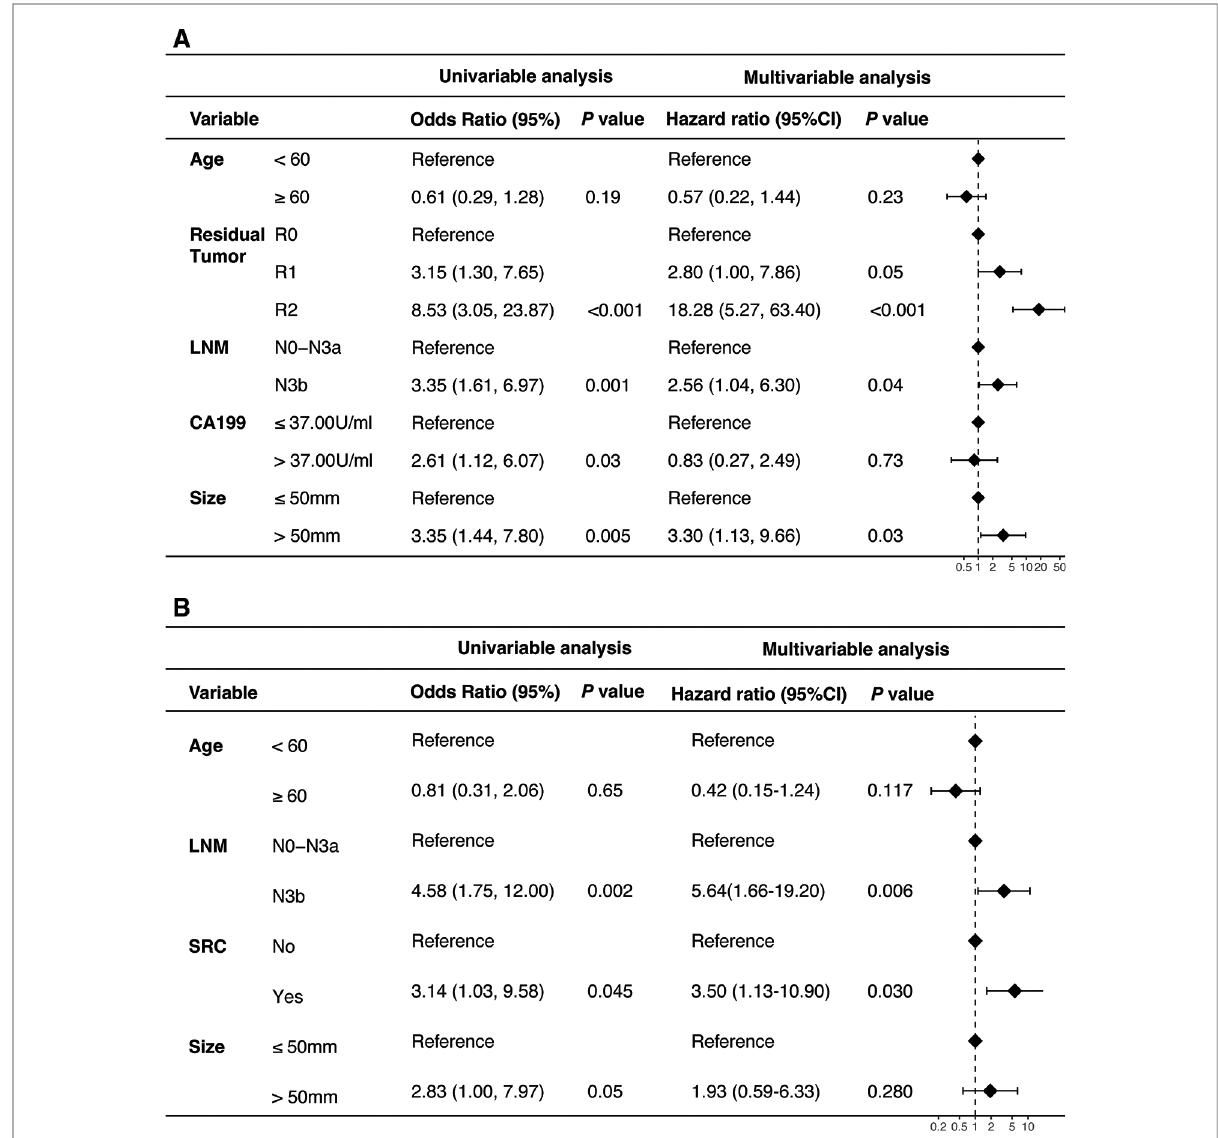
FIGURE 4 Cox proportional hazard regression models and forest plot for recurrence free survival. ( A ) Forest plot of data from multivariate cox regression revealing factors independently associated with peritoneal metastasis of patients with Borrmann type IV gastric cancer. ( B ) Forest plot of data from multivariate cox regression revealing factors independently associated with peritoneal metastasis of patients with Borrmann type IV gastric cancer after receiving R0 resection. (LNM, lymph node metastasis; SRC, signet ring cell; CI, con fi dence